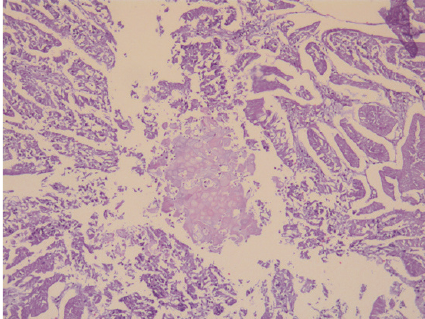
Figure6:H&Estain:degeneratesquamouscellsfoundinsuperficial areas of the uterine